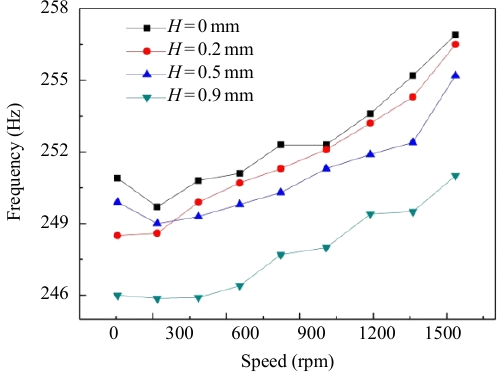
Fig. 8 Relationship between the blade natural frequency and